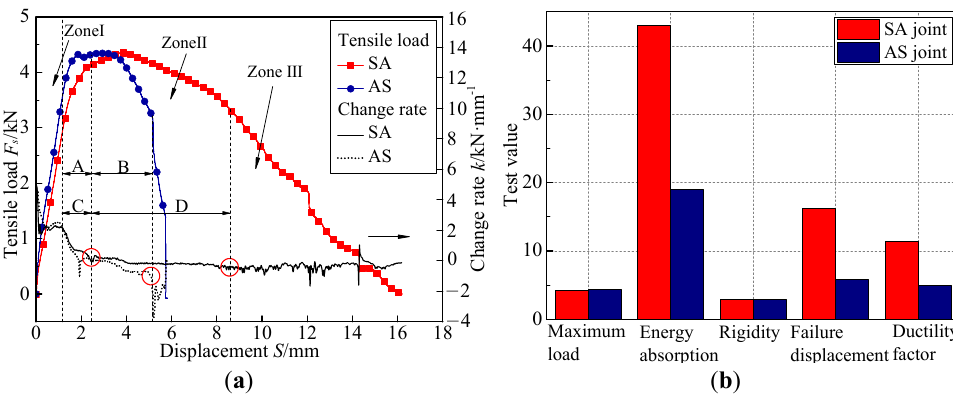
Figure 8. Tensile property of single-rivet joints. ( a ) F s - S curves and k - S curves; ( b ) test values.